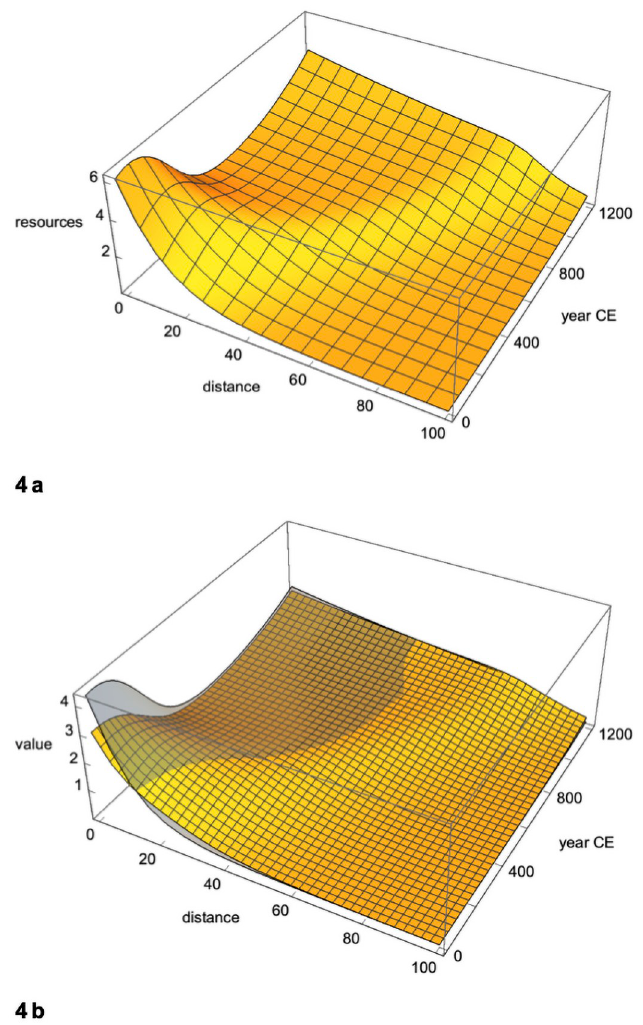
Fig 4. From barbarigenesis to collapse to recovery. a. Resources. Starting in the year 0 with resources falling off exponentially with distance, resources tend to (a) increase logistically over time, (b) diffuse in space, and (c) decrease over time where there is a positive wealth-power mismatch (after a time lag in the early centuries). Parameter values are chosen to give a least-squares best fit to population estimates. (In this and succeeding figures we start the first millennium with the year 0 rather than the year 1, which is more computationally convenient.). b. Production and income, given resources as in 4a. The gray surface is production, the tan surface is income. Initial values (year 0) equal production and income in Fig 3. Wealth-power mismatch spreads but ebbs over